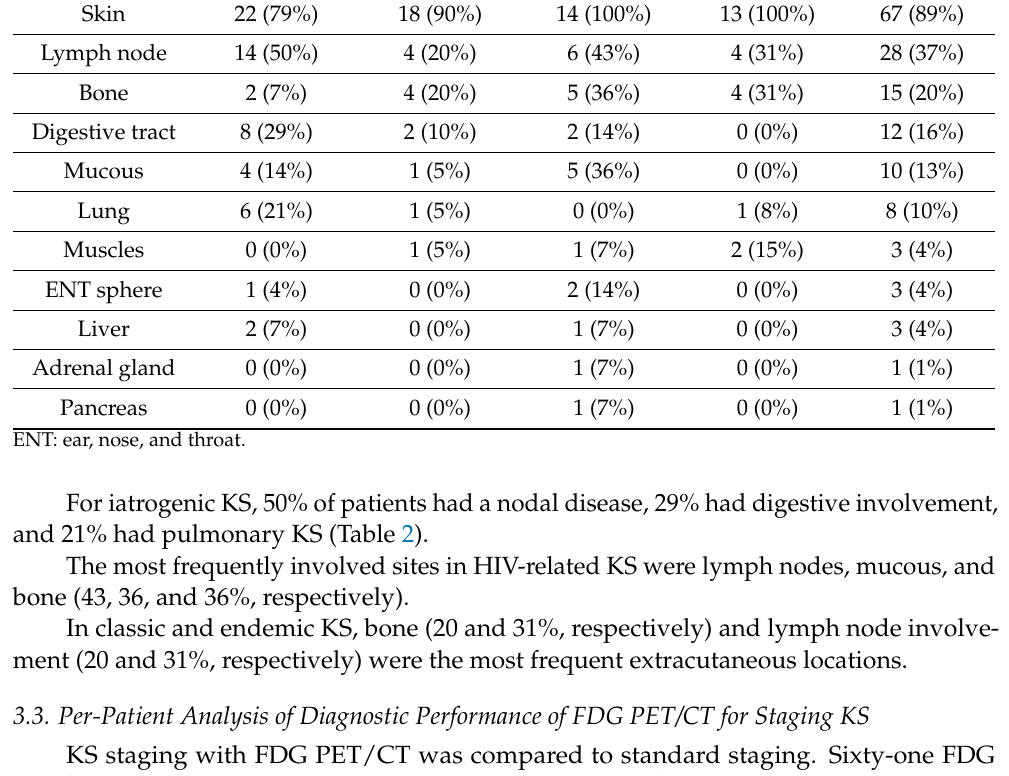
Table 2. Distribution of involved sites according to KS type (standard staging). Iatrogenic